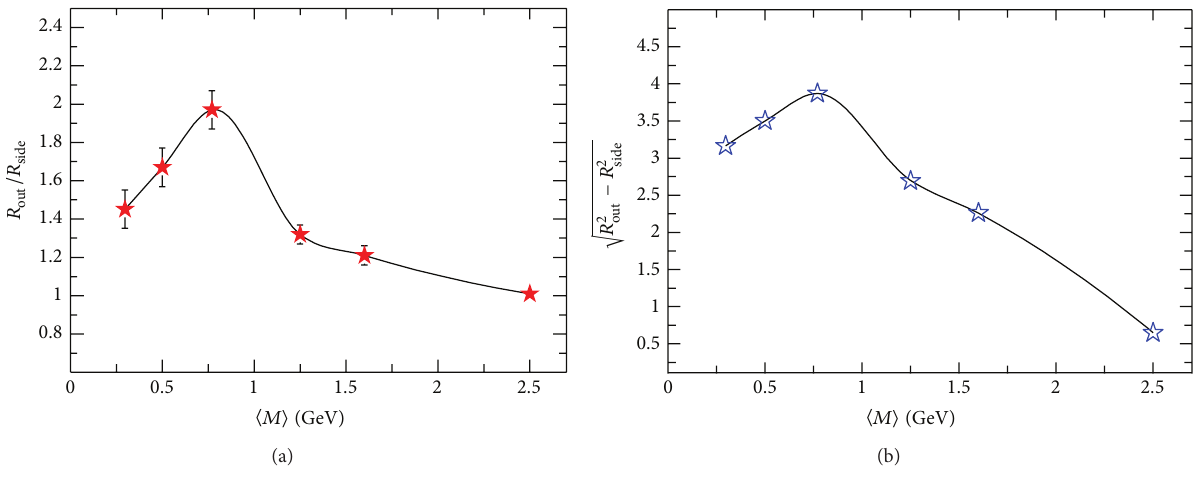
/𝑅 and the difference √𝑅 2 out side